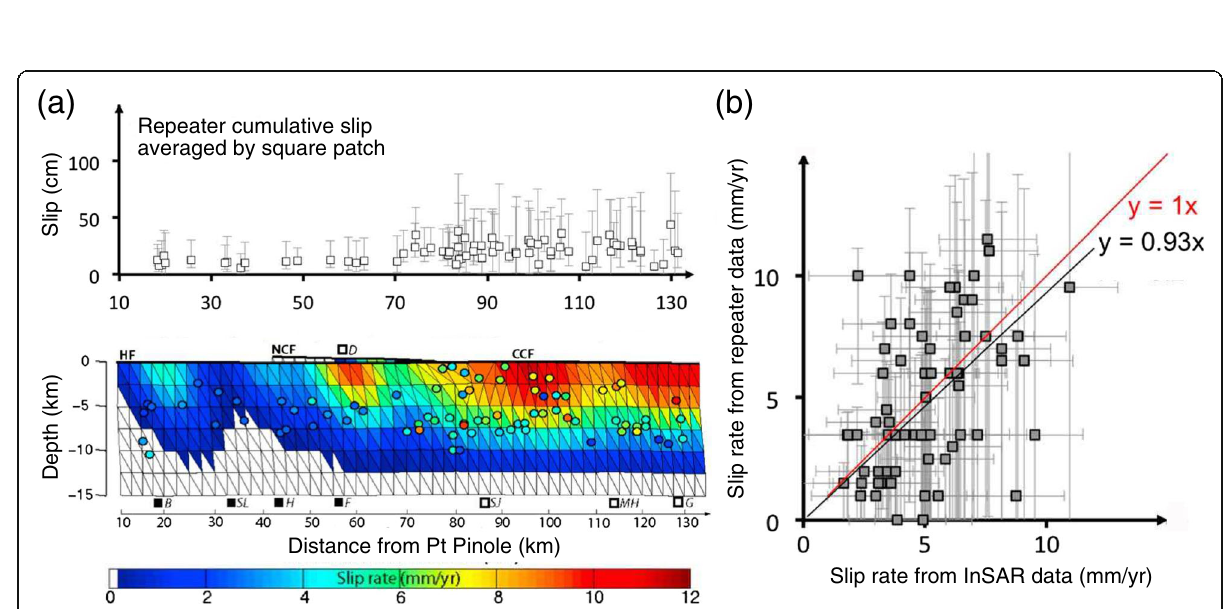
Fig. 14 Comparison of InSAR-derived slip rates and repeater-derived slip rates along the Hayward-Calaveras fault zone, California (after Chaussard et al. (2015)). a Repeater slip rates averaged over square patches compared to the modeled slip rates (inverted from InSAR-derived deformation) with same color scale (bottom). b Comparison of repeater slip rates and modeled slip rates both averaged over square patches. The red line shows a 1 to 1 linear regression and the black line shows the best-fit linear